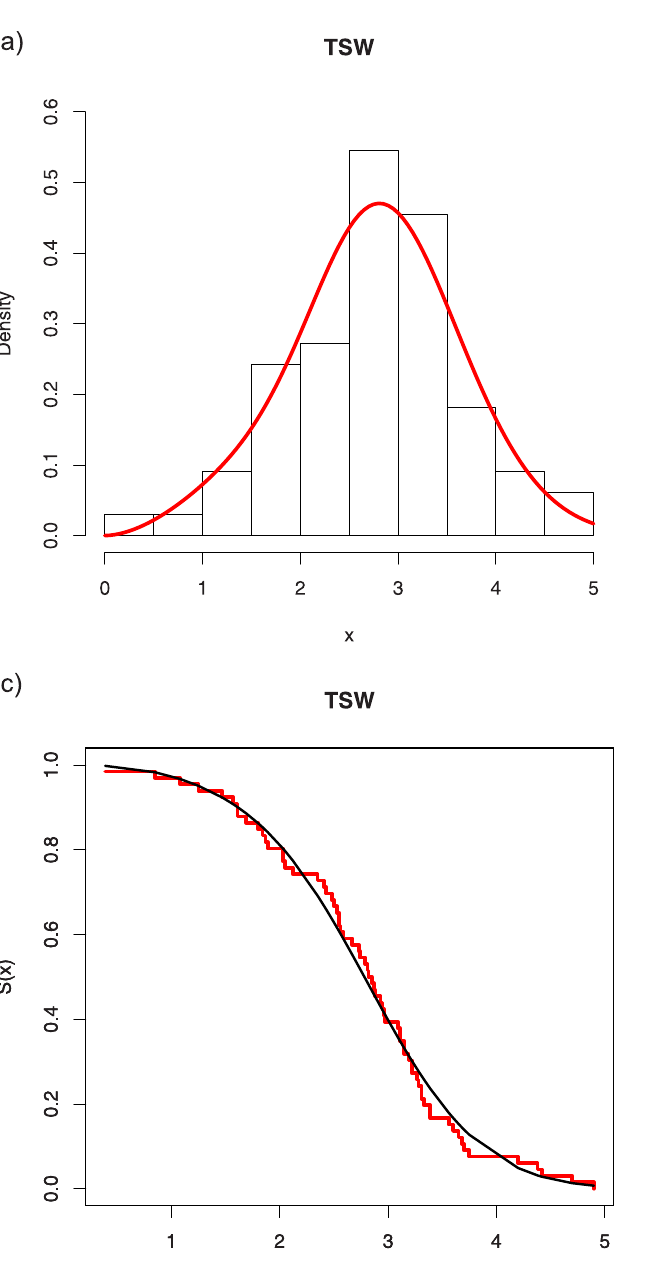
PLOS ONE | https://doi.org/10.1371/journal.pone.0250790 May 11,